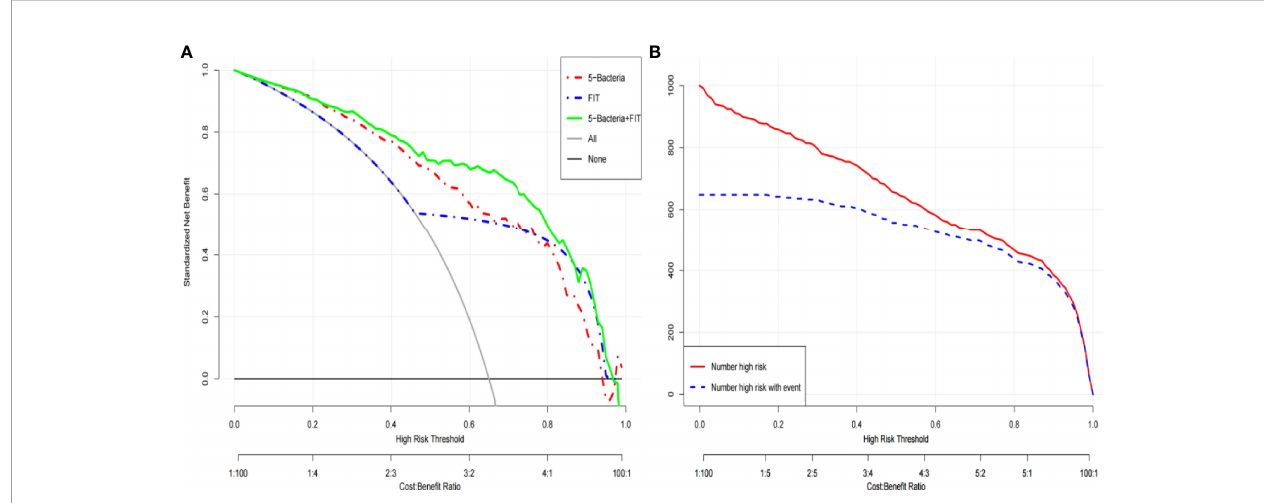
FIGURE 5 | The clinical decision curve (A) and clinical impact curve (B) of the colorectal cancer risk prediction model combined with FIT.